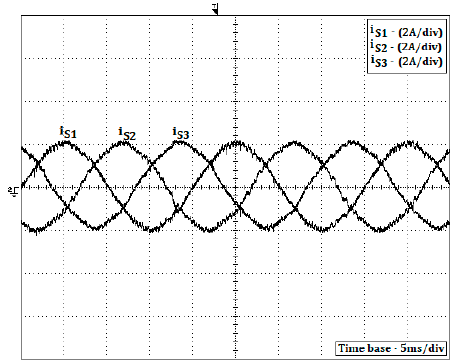
Figure 13. Result of the three-phase charger input currents (i S1 , i S2, and i S3 ).